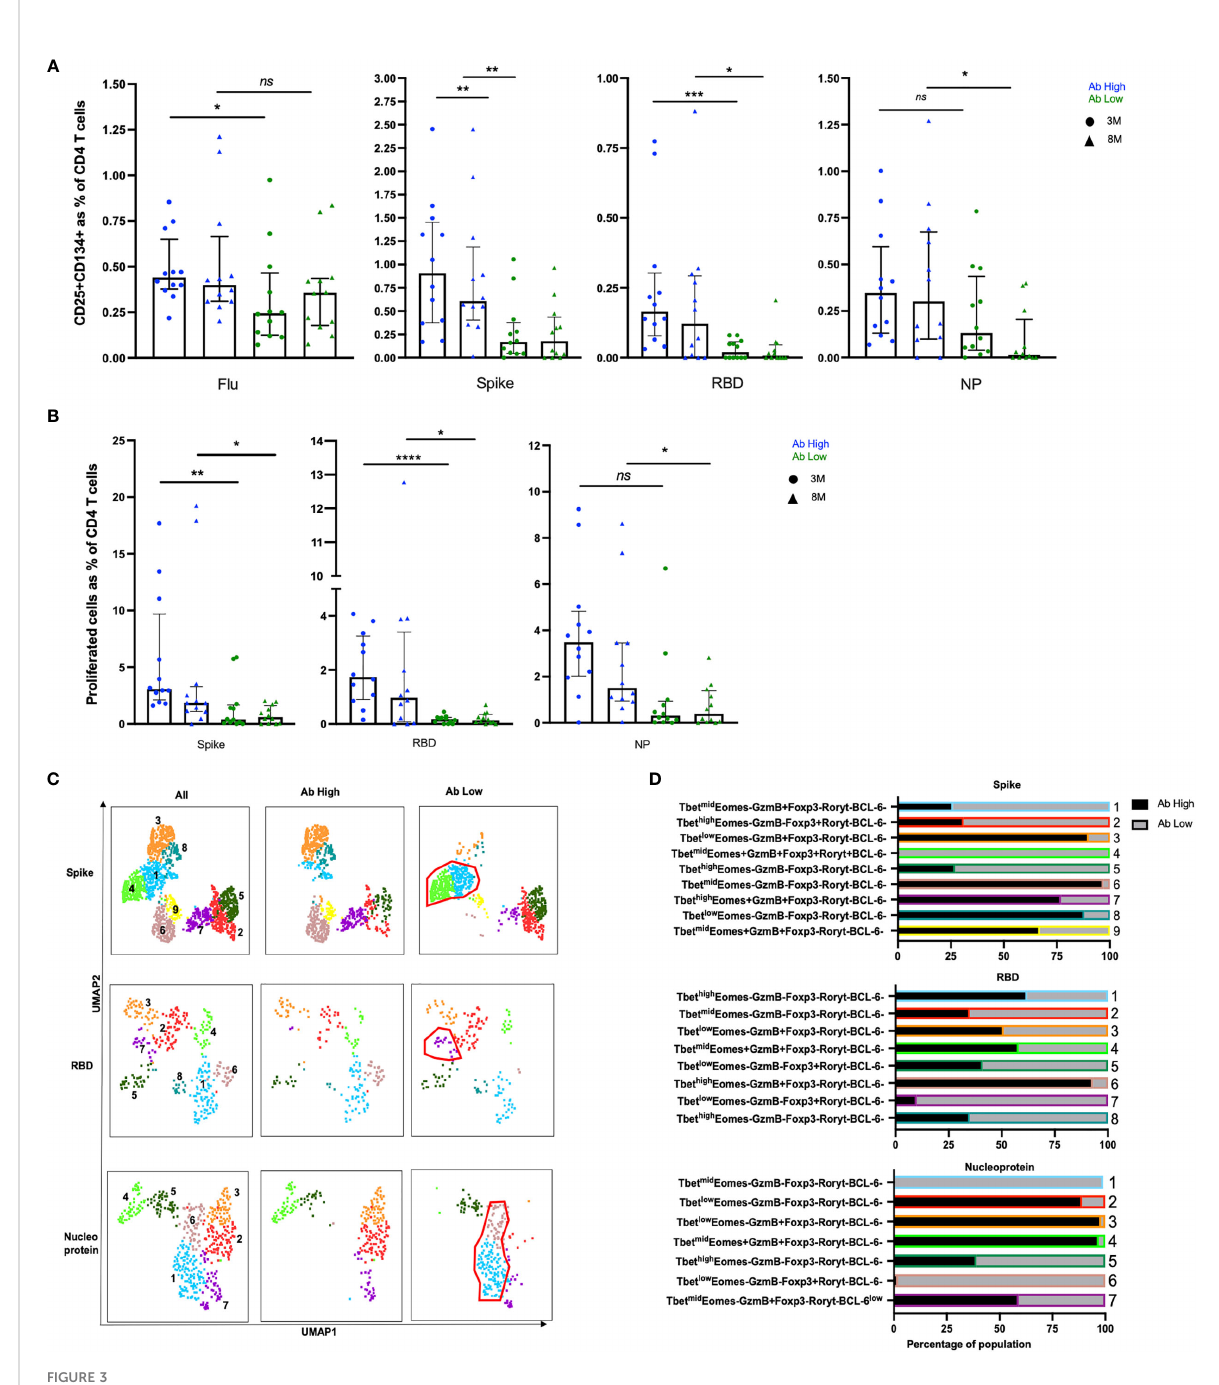
FIGURE 3 Higher frequencies of RBD-speci fi c CD4+ T cells in Ab high group. (A) CD4 responses to in fl uenza, spike, RBD and nucleoprotein (NP) at 3M and 8M post- infection. (B) Higher frequency of SARS-CoV-2 proliferative CD4 T cells in Ab high group compared to Ab low at 3M and 8M. (medians with interquartile ranges). (C) Representative UMAP of proliferated CD4 T cells: concatenated; ab high; and ab low. Red gates are regulatory-like cells present in Ab low subjects. (D) Regulatory-like Foxp3+ cells are higher in Ab low subjects (grey columns) compared with higher effector cells in Ab high subjects (black columns). The colour and number of horizontal bar graphs match with UMAP clusters. Two-tailed p values <0.05 were considered signi fi cant (ns- not signi fi cant, *<0.05, **<0.01, ***<0.001, ****<0.0001). Mann-Whitney T test used for unpaired